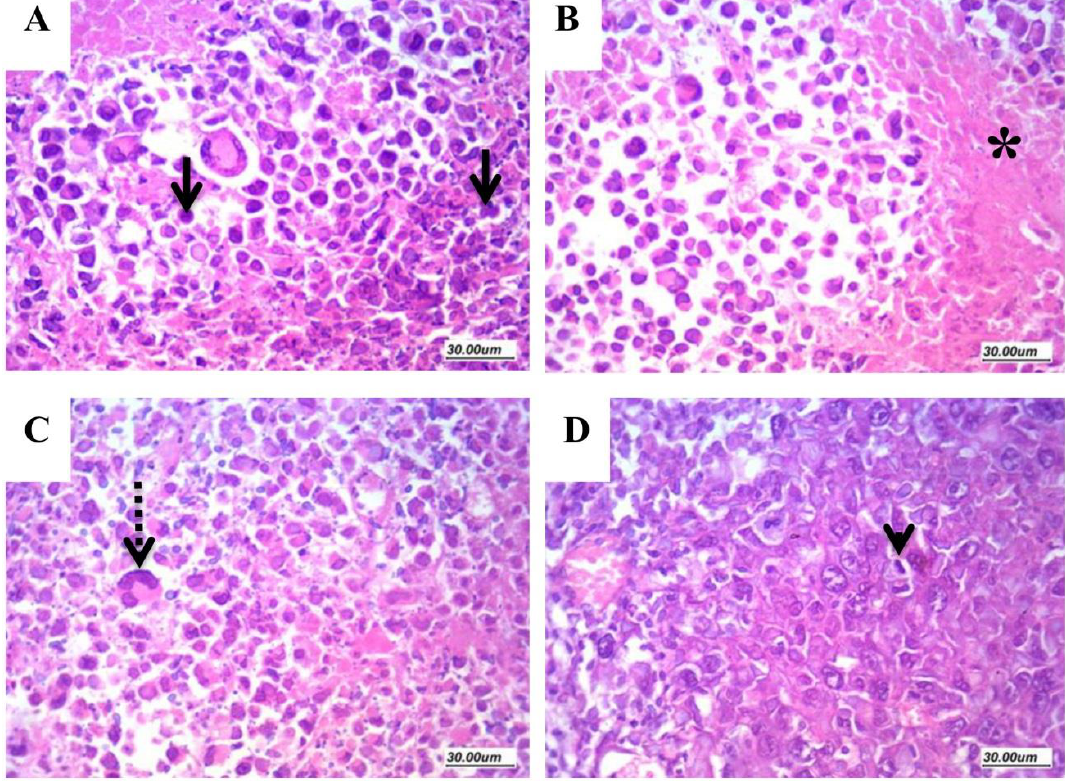
Figure 6. Histopathologic features of solid Ehrlich carcinomas. Sections from the solid tumors stained with H&E ( × 400) showing: ( A ) apoptosis (arrows); ( B ) necrosis (star); ( C ) giant cells (dashed arrow); and ( D ) mitosis (arrow head).